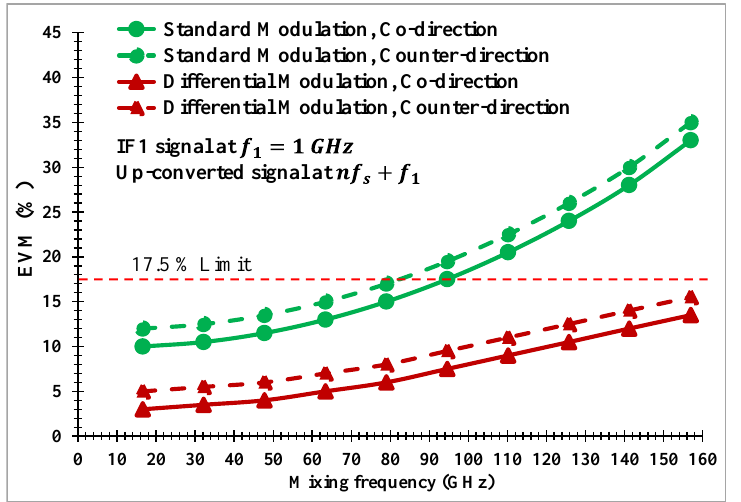
Figure 14. EVM of up-converted QPSK signals from 𝑓 1 = 1 GHz to the mixing frequencies 𝑛𝑓 𝑠 + 𝑓 1 at the bit rate of 100 Gbit/s for the four cases.